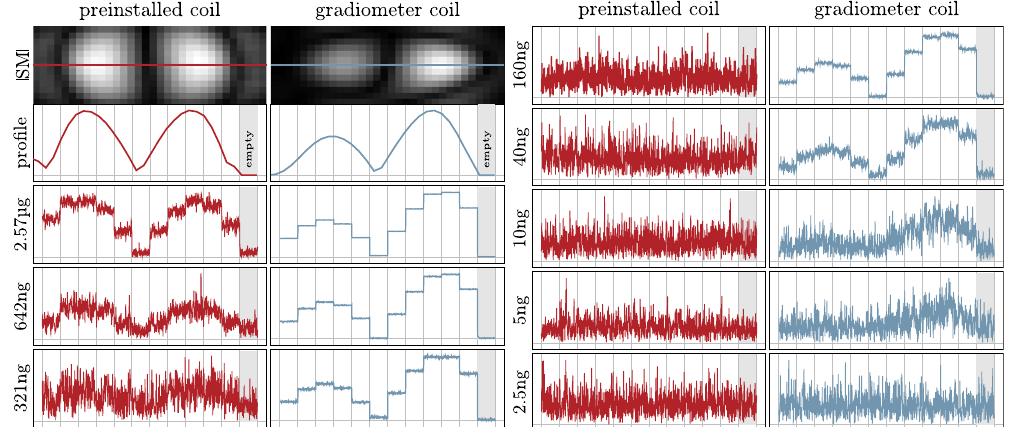
Figure 5. Raw data analysis. The first image shows the absolute value of the SM component with the highest SNR for the preinstalled coil and the gradiometer coil. As the dilution samples are moved on the x axis, the resulting harmonic magnitude over time are expected to match the profile of these patterns shown in the second plot. The dilution raw data plots contain the unprocessed time data of the selected harmonics for the dilution samples at 11 positions in the FOV and a 12th position outside the scanner bore. Thus, the last part of the plot is actually an empty measurement. It is visible that the gradiometer is misplaced slightly causing a non-symmetric influence of the coil